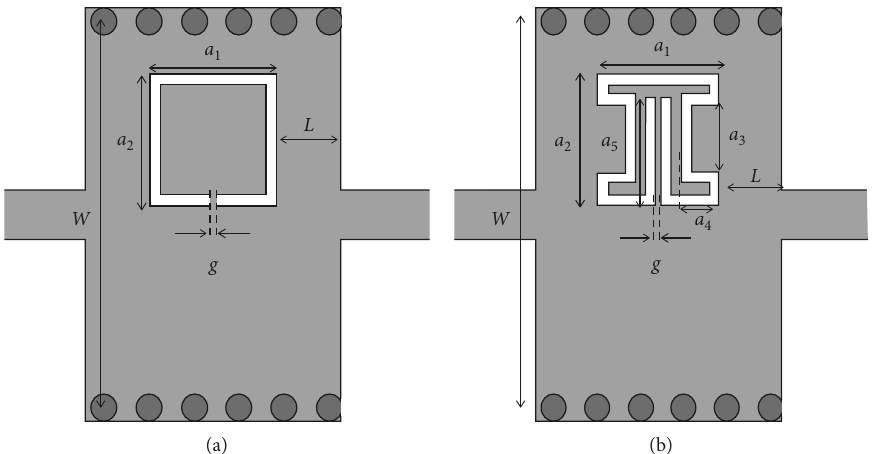
Figure 2: Configurations of (a) the base layout used in [3] and (b) the proposed base layout for SIW-CSRR unit cells [9].